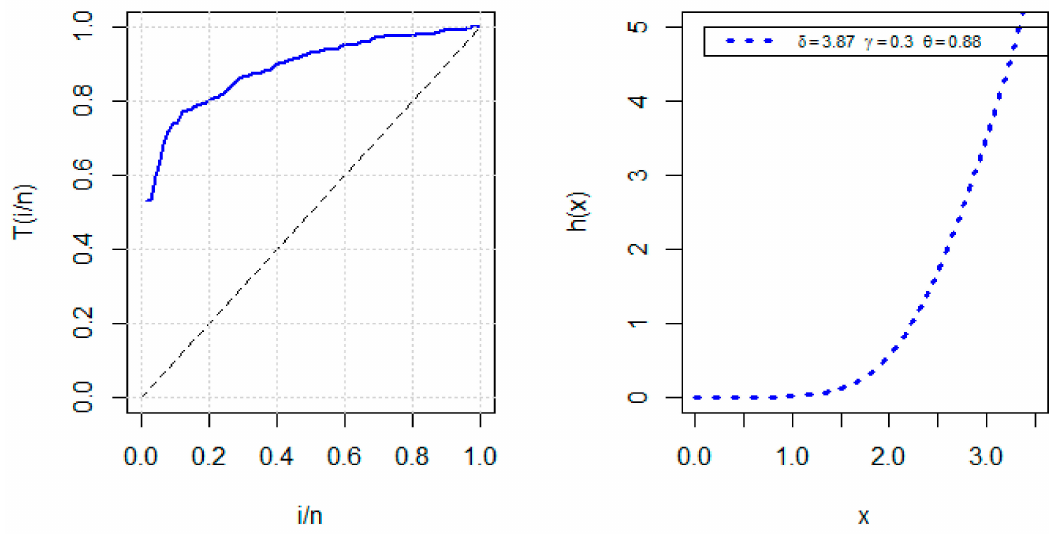
Figure 5. The total time on test (TTT) plot ( left panel ) and the OEHLE HRF plot ( right panel ) for the gauge lengths